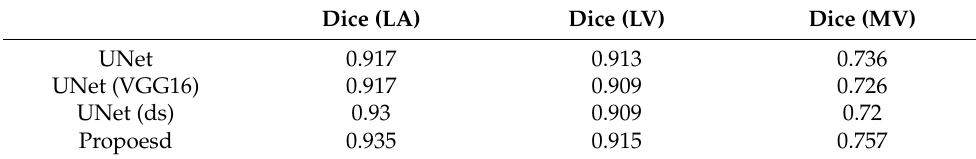
Table 4. Effectiveness